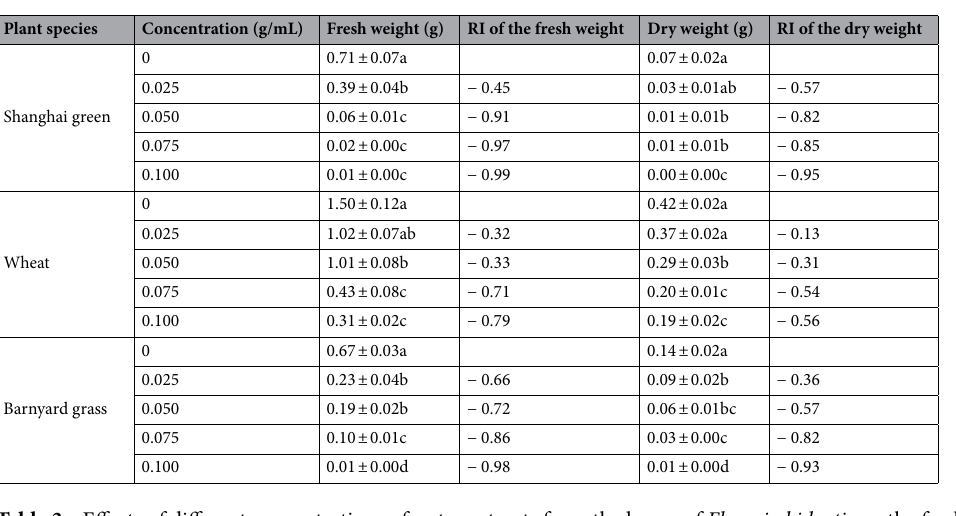
Table 3. Effects of different concentrations of water extracts from the leaves of Flaveria bidentis on the fresh and dry weights of three plants. Data are shown as the mean ± standard deviation. Different letters in the same column for each treatment indicate significant differences at the P < 0.05 level, while the same letter indicates no significant difference at the P < 0.05 level.